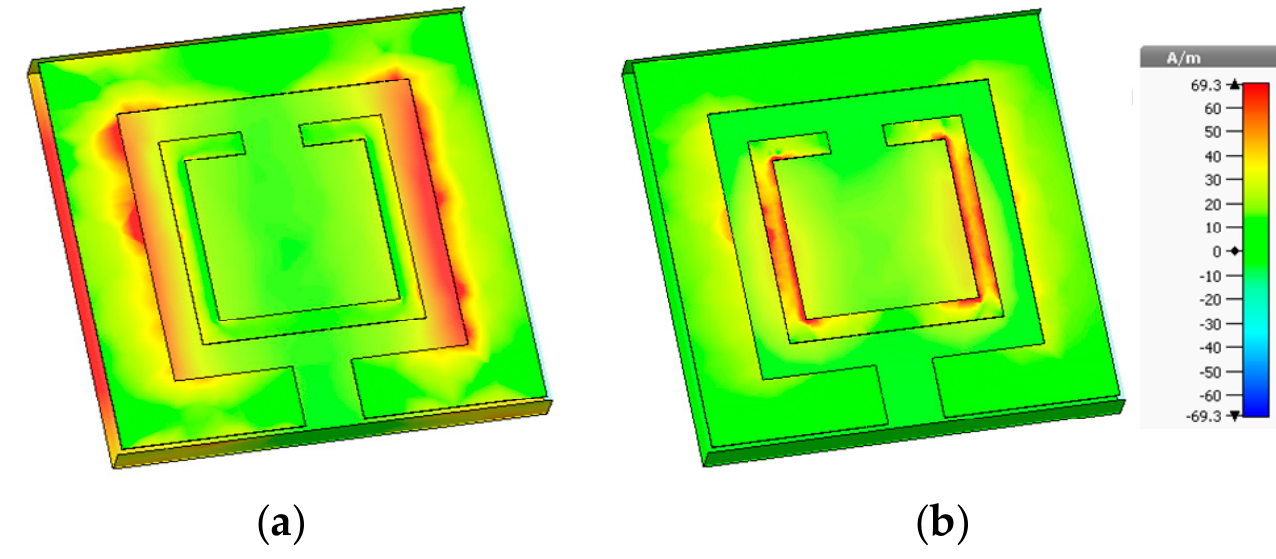
Figure 14. Surface current distribution of the AMC unit cell at: ( a ) 2.45 GHz; ( b ) 5.8 GHz.